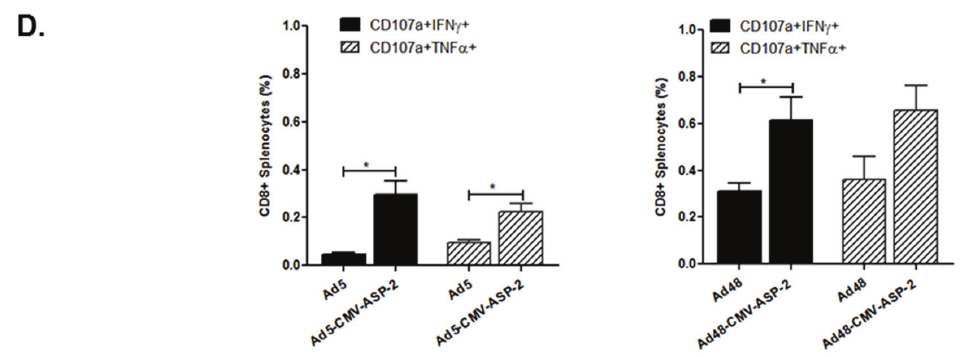
Figure 4. Frequencies of double positive phenotypes of ASP-specific T-cell responses in immunized mice. ( A ) Study design: C57BL/6 mice were immunized intramuscularly with Ad5, Ad5-CMV-ASP-2, Ad48, or Ad48-CMV-ASP-2 at the indicated time points. Two weeks after the last immunization, splenocytes harvested from a subset of mice were stimulated with anti-CD107a and GolgiStop in the presence or absence of ASP-C peptide. Cells were gated by side scatter area (SSC-A); forward scatter area (FSC-A); and gated for CD3 + CD4 + or CD3 + CD8 + T lymphocytes; ( B ) Representative flow cytometry plots of CD107a + and IFN γ + by CD8 + T-cells from the spleens of the immunized mice; ( C ) Percentages of CD4 + T-cells which produce CD107a + IFN γ + or CD107a + TNF α + after stimulation with ASP-C peptide; ( D ) Percentages of CD8 + T-cells which produce CD107a + IFN γ + or CD107a + TNF α + after stimulation with ASP-C peptide. Results are presented as the mean ± SEM frequencies of CD4 + or CD8 + cells for 4 mice. (*) = p (cid:8) 0.05.